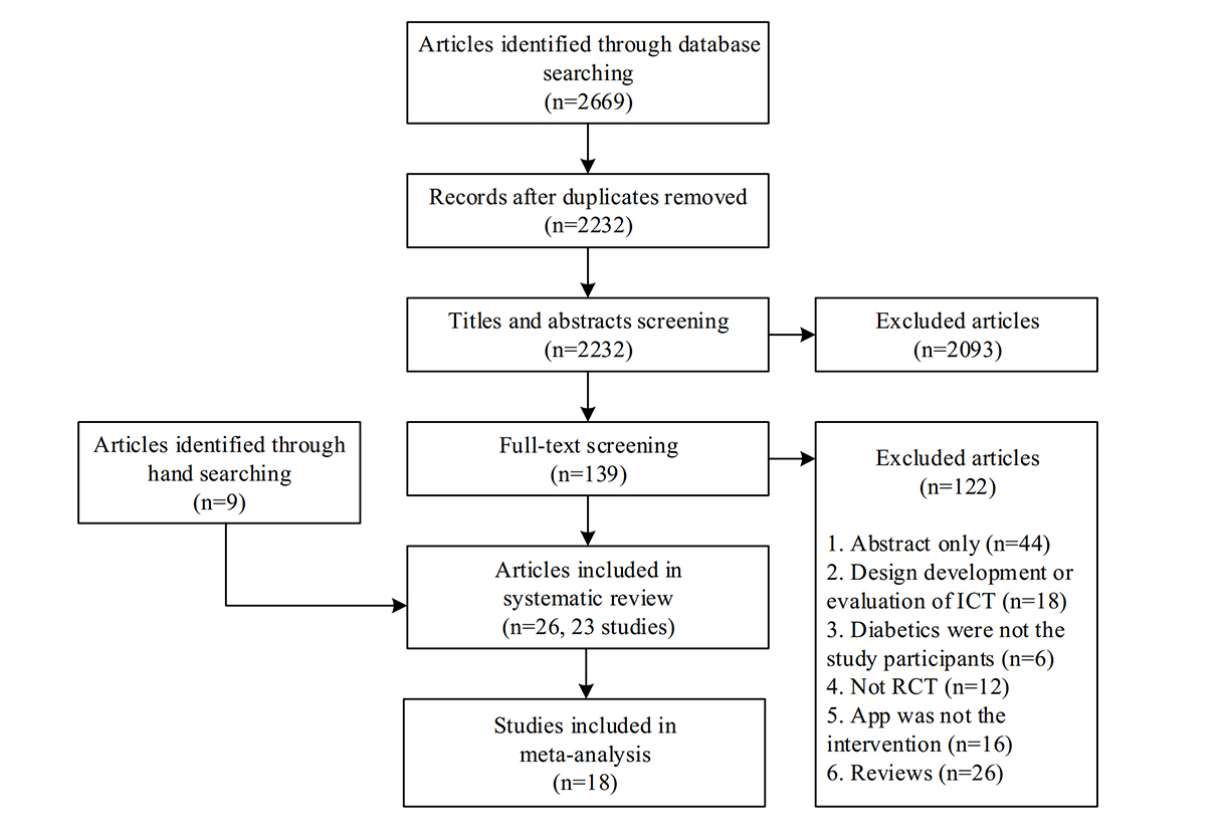
Figure 1. Preferred Reporting Items for Systematic Reviews and Meta-Analyses flowchart of included studies. ICT: information and communication technology; RCT: randomized controlled